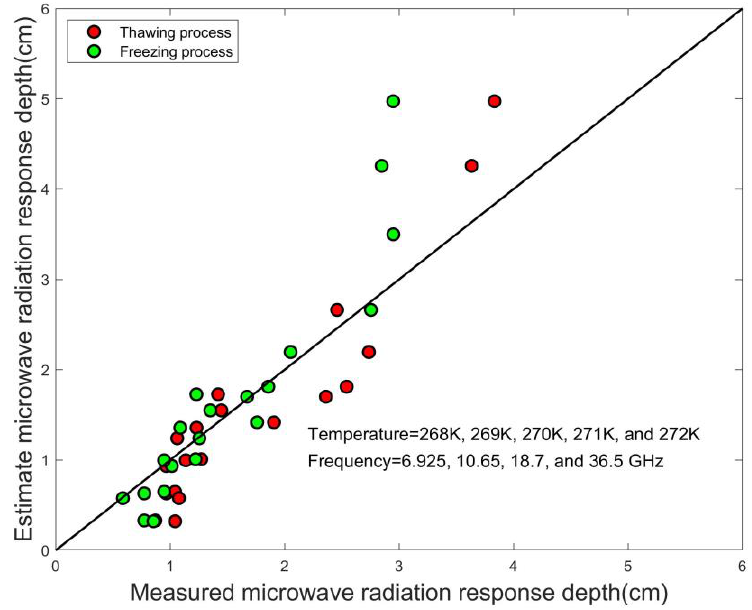
Figure 12. Comparison of measured and estimated MRRDs using the parameterized model.